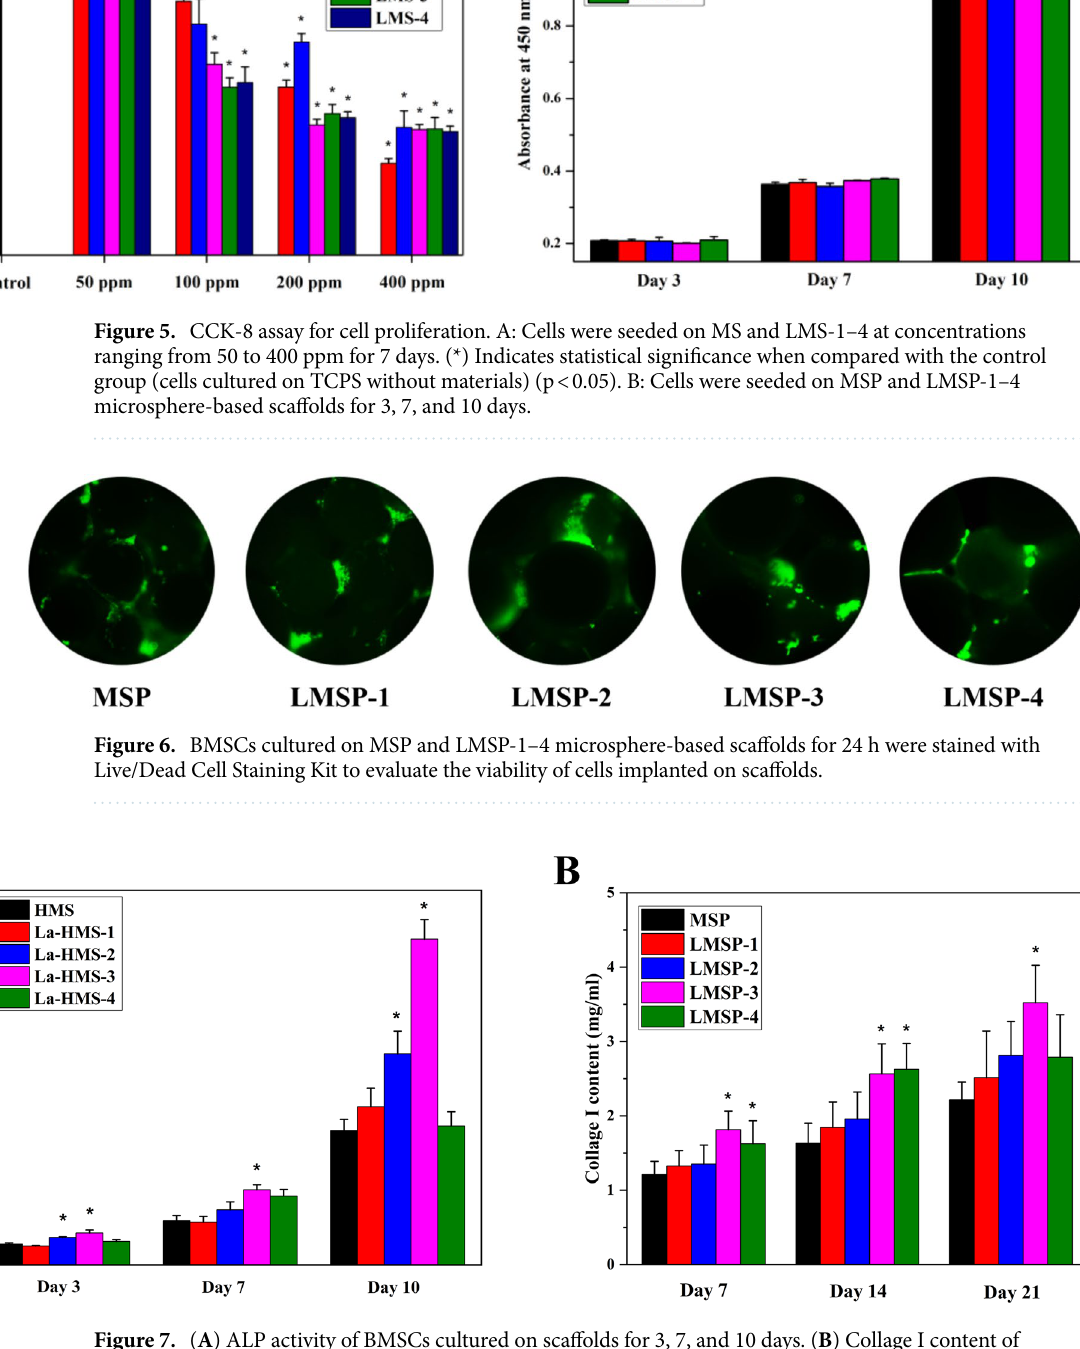
Figure 7. ( A ) ALP activity of BMSCs cultured on scaffolds for 3, 7, and 10 days. ( B ) Collage I content of BMSCs cultured on scaffolds for 7, 14, and 21 days. (*) means the difference was statistically significant (p < 0.05) when made a comparison to the MSP